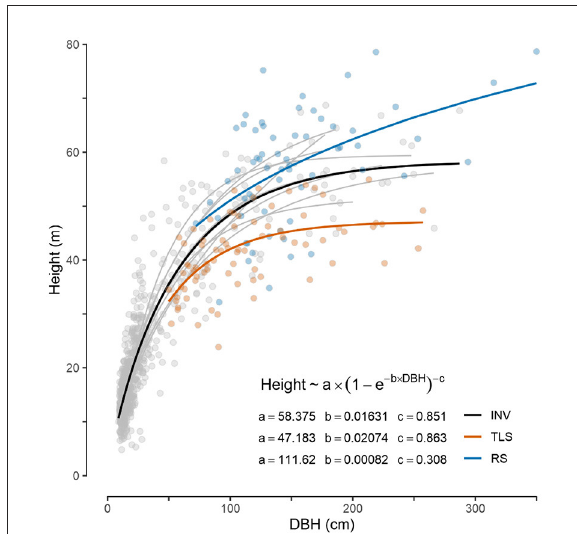
FIGURE7 Scatter plot of tree height versus diameter at breast height (DBH) for the three groups of trees that were measured: INV, conventional tree inventories in 10 sites across the landscape; TLS, individual extracted trees from terrestrial laser scanning data of the inventory plots; RS, field-verified trees that have been identified by remote sensing. Colored lines show a non-linear least-squares regression fit (Richards growth function) for each group to indicate the overall tendency of the relationship. Parameter estimates are given next to the legend (initial guesses were set to a = 75, b = 0.01, c = 1). Thin gray lines show fit for INV data at individual